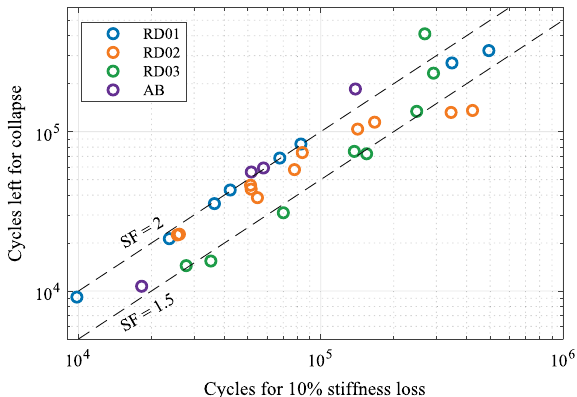
Figure 12. Cycles left until collapse for FCCm structures with different relative densities depending on cycles at 10% stiffness loss.